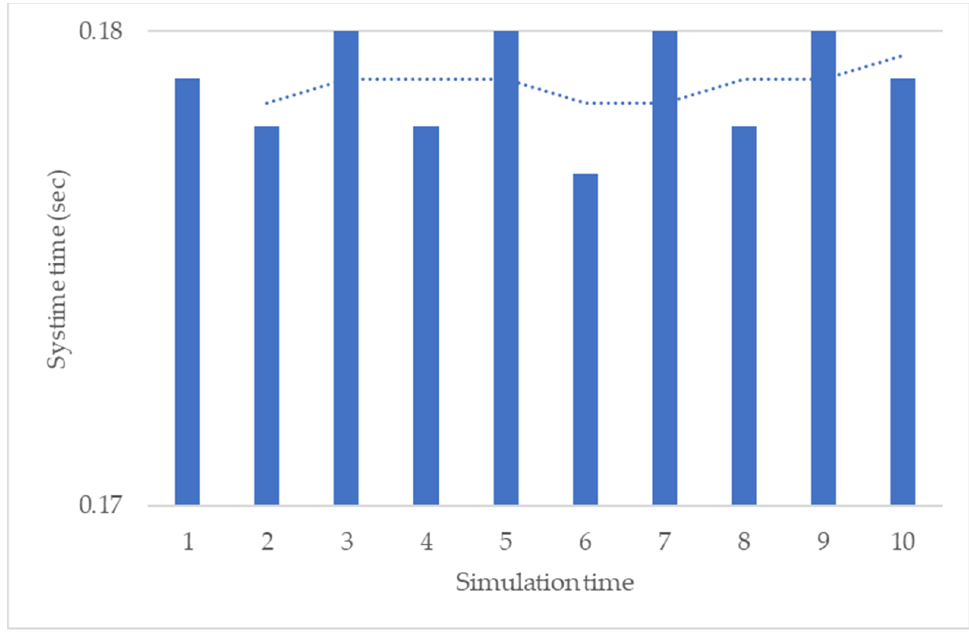
Figure 10. The results of the resource pool.